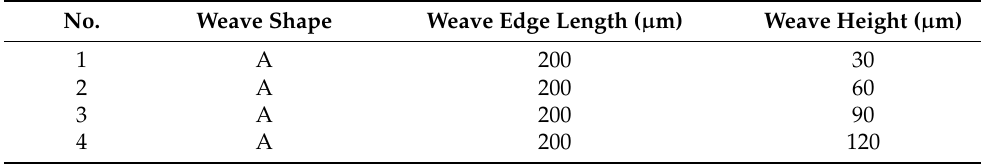
Table 8. Parameter design for experiments on the effect of weave height.